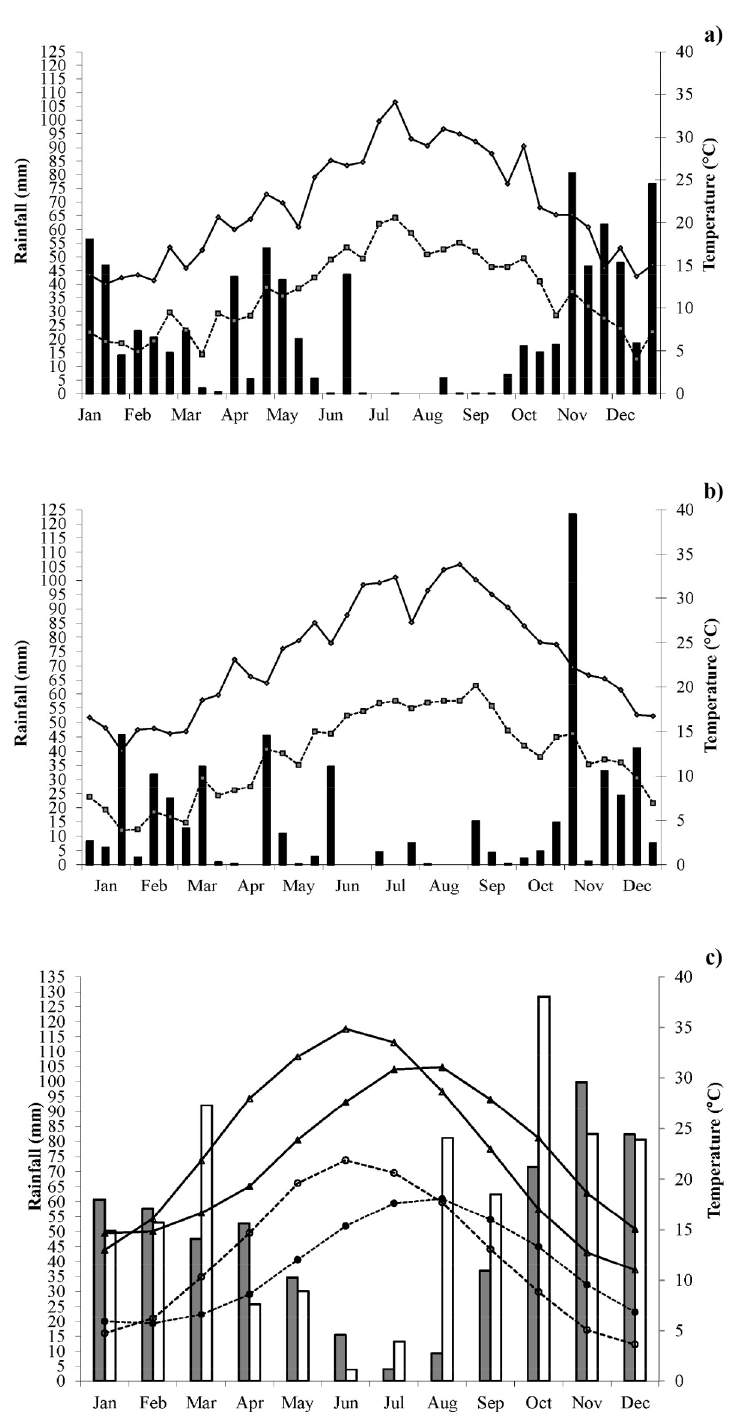
Fig 1. Growing season climate of the study site. Rainfall (bars), maximum (solid line) and minimum (dashed line) temperatures in the years 2010 (a) and 2011 (b). Rainfall (grey bars), maximum (solid line and filled triangle), minimum (dashed line and filled circle) temperatures for fifty-three years: from 1 January 1959 to 31 December 2011 (c). Rainfall (white bars), maximum (solid line and open triangle), minimum (dashed line and open circle) temperatures for eighty-four years of future climate: from 1 January 2012 to 31 December 2095 (c). Rainfall values are sums (a and b) and 84 years average of monthly sums (c); temperature values are means, over 10-day periods (a and b) and 84 years average of monthly means (c).